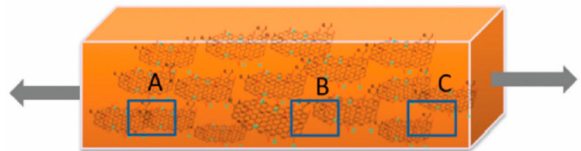
Figure 24. Schematic demonstration of the mechanisms electromechanical behaviors of